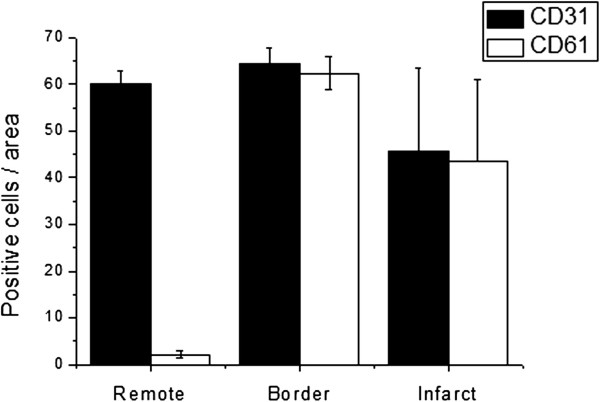
Vascular density (CD31) and β3 integrin expression (CD61) in remote, borderzone and infarct areas. Average ± SD of positive counts of 10 high power field (×400 magnification).